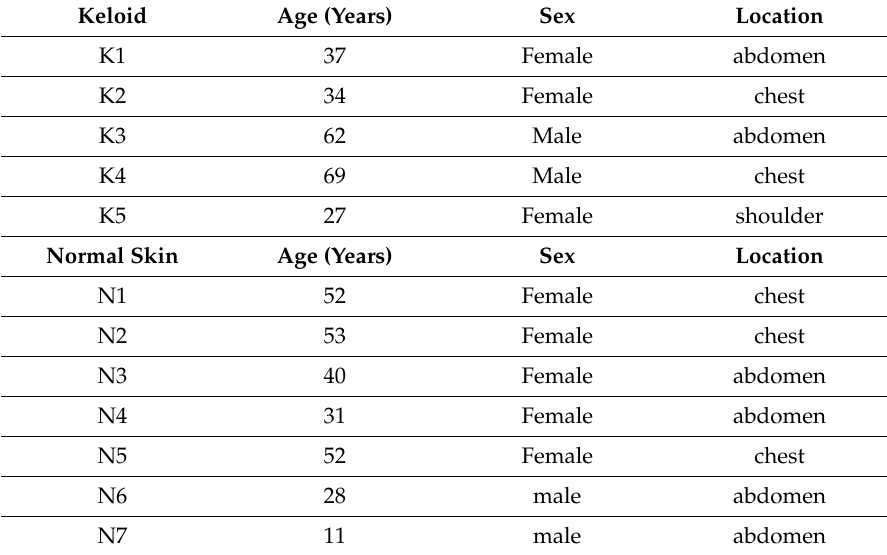
Table 1. Characteristics of the patients enrolled in this